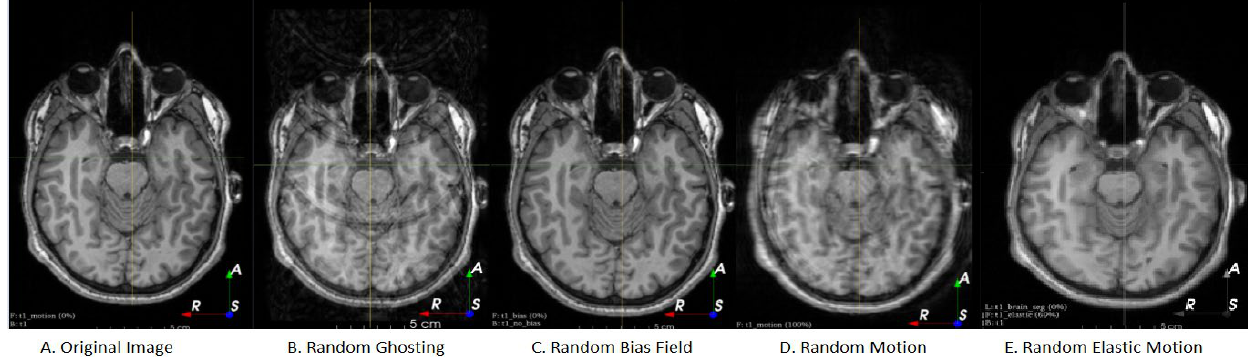
Figure 2. Extended set of transformations specifically used for biomedical imaging applications.